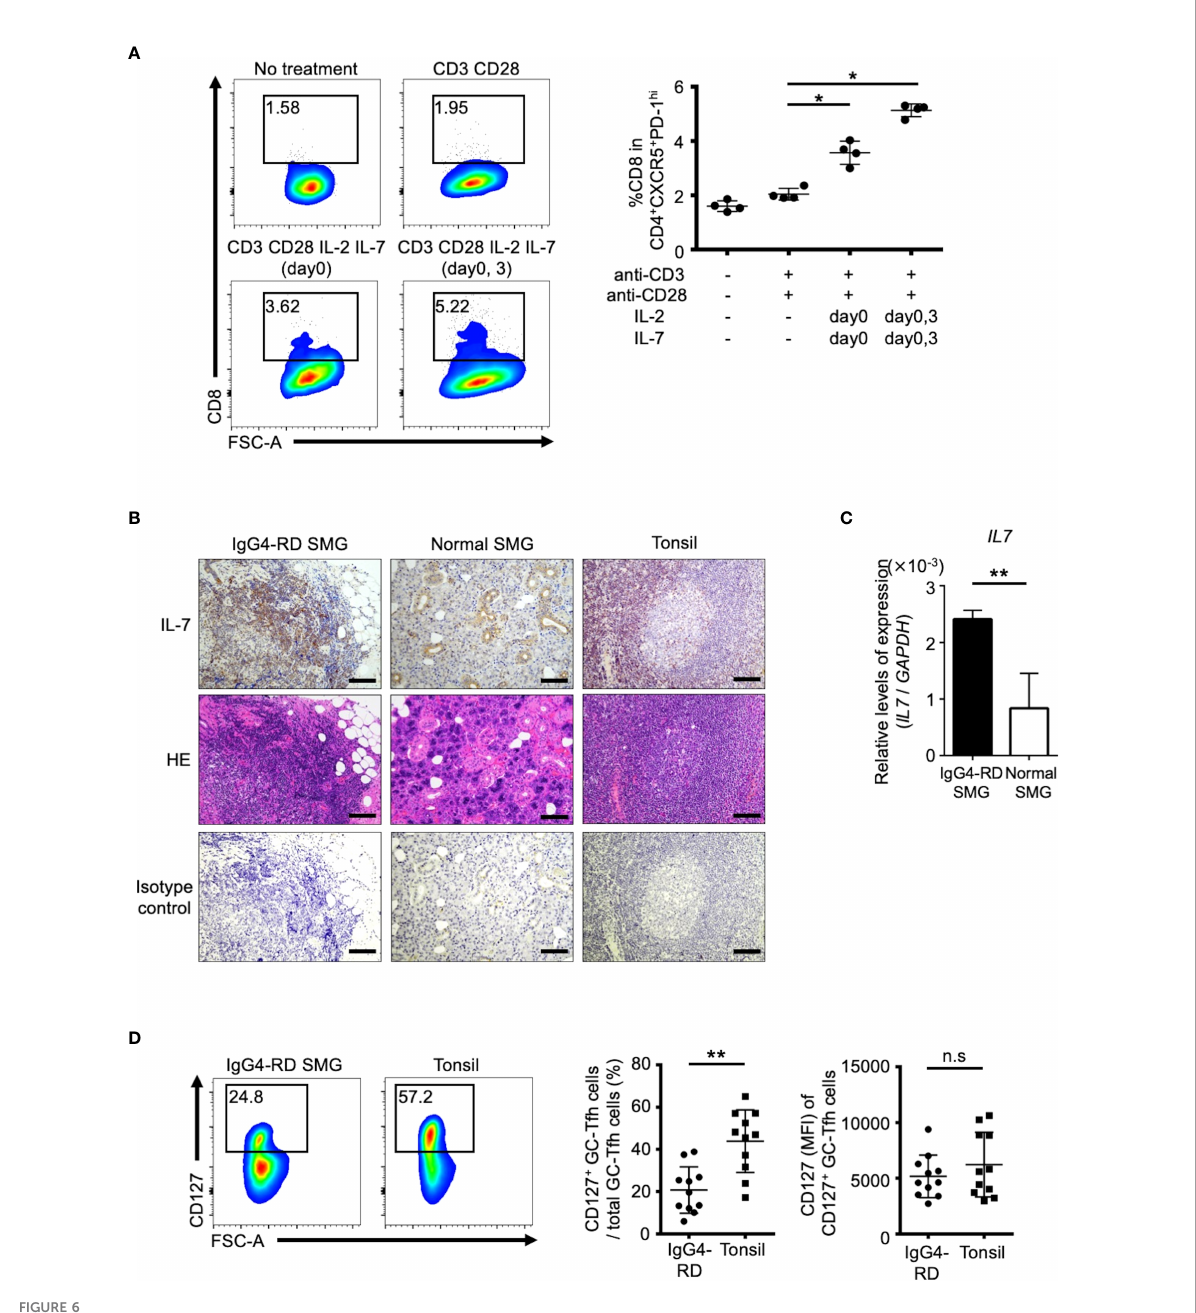
FIGURE 6 SP-Tfh cells are the possible origin of DP-Tfh cells. (A) Upregulation of CD8 on SP-Tfh cells (CD3 + CD4 + CD8 - CXCR5 hi PD-1 hi ) under the stimulation of IL-2 and IL-7. SP-Tfh cells (5×10 4 cells/well) from tonsils (n = 4) were incubated in 200 m L of AIM-V medium with or without 2 m g/mL anti-CD3 and 2 m g/mL anti-CD28 mAbs. Under the stimulation of CD3 and CD28, 20 ng/mL IL-2 and 20 ng/mL IL-7 were added once on day 0 or twice on days 0 and 3. On day 7, cells were analyzed by fl ow cytometry. Representative fl ow cytometry pro fi les are shown on the left. Data obtained from four independent experiments are summarized in a graph on the right. (B) Histological examination of IL-7 expression. Immunohistochemistry of IL-7 in SMG lesions of IgG4-RD, normal SMG tissues, and tonsils are shown in the upper panels. The HE-stained images and isotype controls for immunohistochemistry in the corresponding tissue areas are shown in the middle and lower panels, respectively. Scale bar: 100 m m. (C) Relative expression levels of IL-7 in SMG lesions of IgG4-RD (n = 4) and normal SMG (n = 4) assessed by RT-qPCR analysis. GAPDH was used as a control. (D) Representative fl ow cytometry pro fi les showing the presence of CD127 on GC-type Tfh cells (CD3 + CD4 + CXCR5 hi PD-1 hi ) in IgG4-RD lesions of SMGs and tonsils (left). The percentages of CD127 + GC-type Tfh cells among the total GC-type Tfh cells in IgG4-RD lesions and tonsils (right). Values of the mean fl uorescence intensity (MFI) of CD127 on GC-type Tfh cells in the two groups are also shown (IgG4-RD, n = 11; tonsil, n = 11). Data in (A, C, D) were analyzed by the Mann – Whitney U